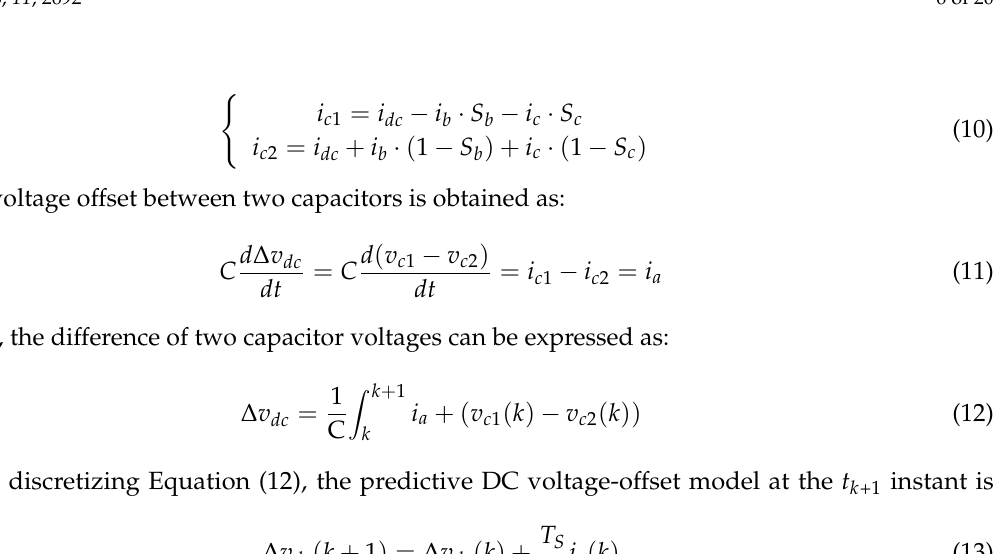
S b S c S b S c Figure 4. Duration and operation sequence diagram of voltage vector under each sector.